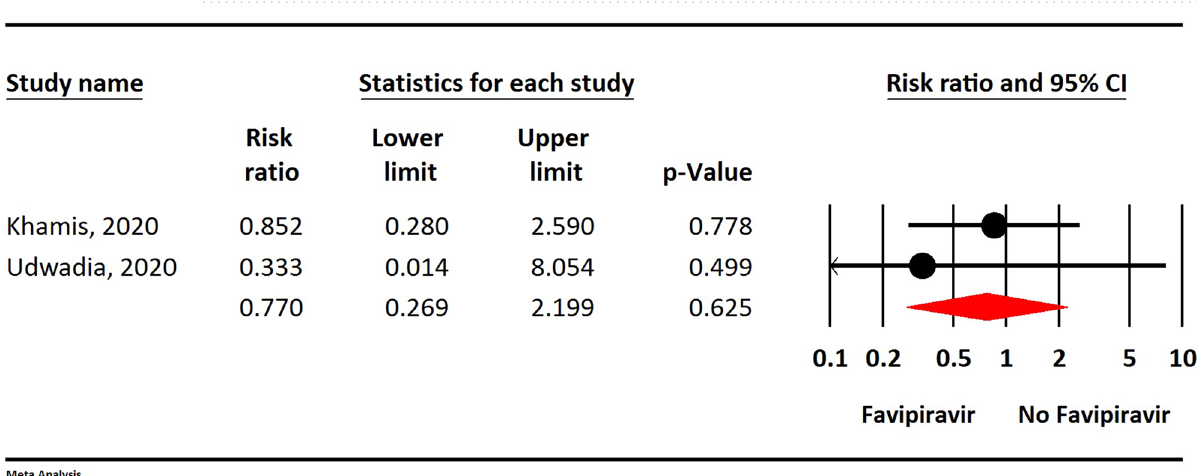
Figure 1. The updated meta-analysis of viral clearance of Favipiravir on COVID-19 patients after removal of Dabbous et al. data (Orange diamond: summary of sub groups; Red diamond: summary of total).